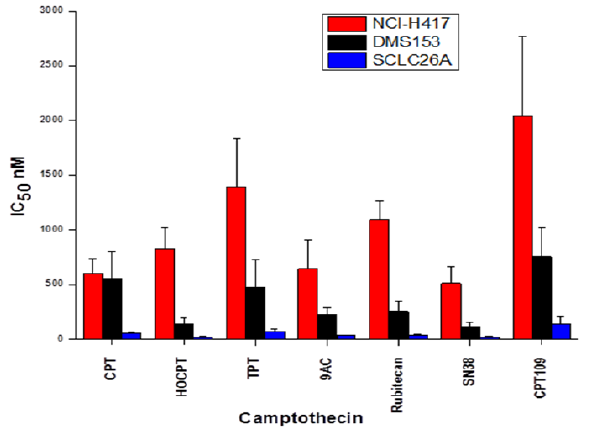
Figure 2. CPT, 10-hydroxy-CPT (HOCPT), topotecan (TPT), 9-aminocamptothecin (9AC), rubitecan, SN38 and CPT109 were tested for their cytotoxicity against NCI-H417, DMS153 and SCLC26A SCLC cell lines using MTT assays. IC mean ± SEM ( n =